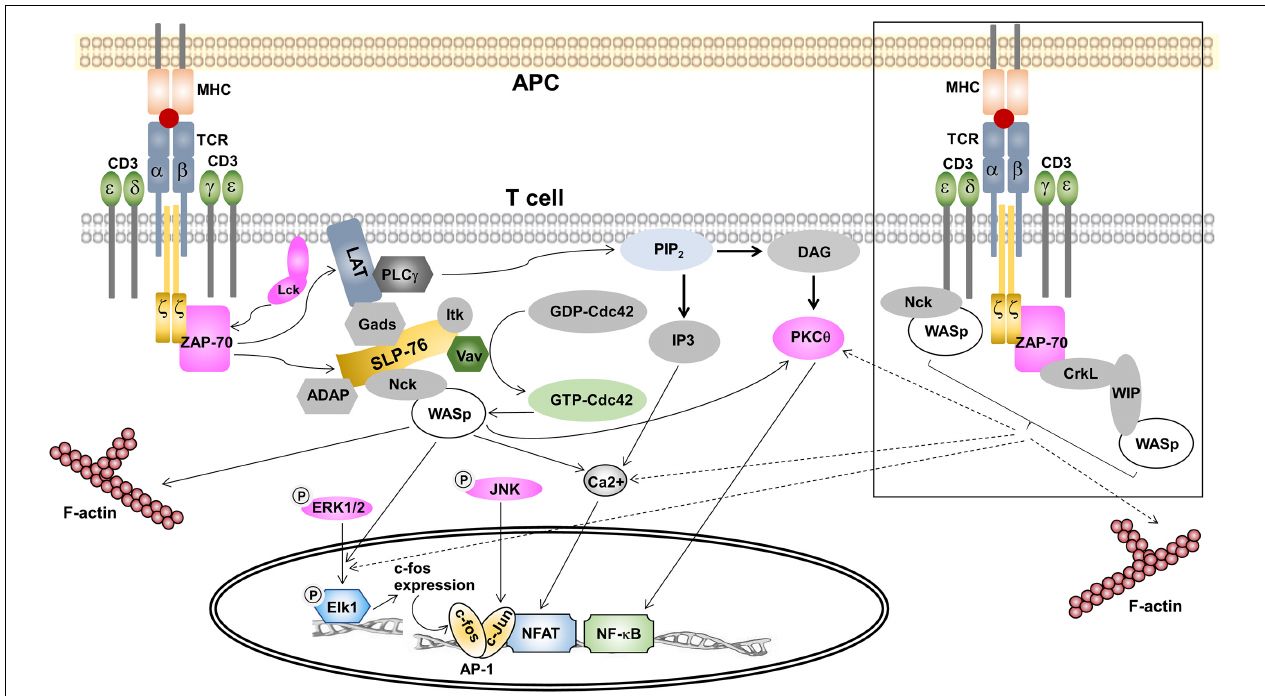
FIGURE 2 | The role of WASp in signal transduction in T cells. TCR ligation with pMHC triggers signal transduction within the cytoplasm of T cells. Once phosphorylated by ZAP-70, phospho-LAT recruits proteins to form the LAT/SLP-76 signalosome containing Nck and Vav. Vav activates the Rho GTPase Cdc42, which in turn interacts with WASp. This complex is recruited to the signalosome via Nck. In association with GTP-Cdc42, WASp is released from the auto-inhibited conformation and then initiates the ARP2/3-dependent F-actin polymerization. In Ras/Rac-MAPK pathway, WASp is essential for the translocation of phospho-Erk1/2 into the nucleus. Once in the nucleus, phospho-Erk1/2 phosphorylates Elk1, which then causes c-fos expression, a component of transcription factor AP-1. WASp was not required for the activation of Jnk, a kinase causing c-jun expression that is the second component of AP-1. In the PKC pathway, WASp contributes to PKC θ activation in response to low doses of antigen. Activated PKC θ is required for activation of transcription factor NF- κ B and its nuclear translocation. For Ca 2 + -mediated signaling, WASp is indispensable for intracellular Ca 2 + mobilization, which is essential for NFAT translocation to the nucleus. In the squared box, two alternative pathways of WASp recruitment to TCR are shown. Firstly, WASp is constitutively associated with Nck and Nck-WASp is recruited to the TCR upon TCR ligation. Secondly, preformed CrkL-WIP-WASp is recruited to ZAP-70 following T cell activation. We propose that these two recent identified pools of WASp play a role in controlling actin polymerization and may contribute to the nuclear translocation of phospho-Erk1/2, PKC θ -mediated NF- κ B activation and Ca 2 +